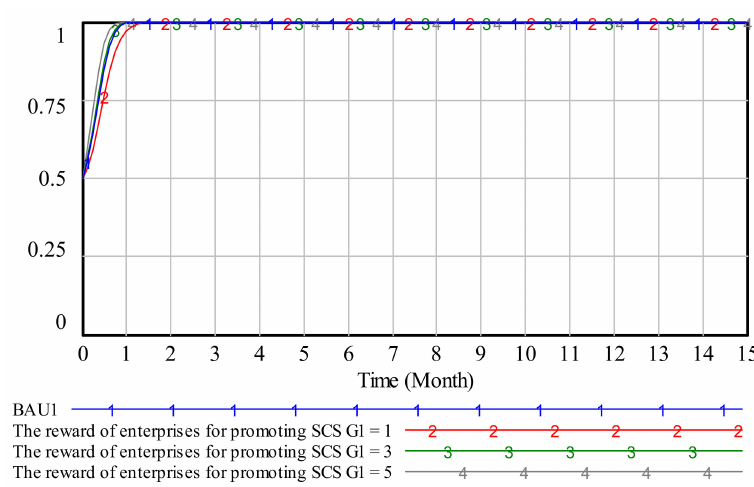
Figure 12. Impact of P 1 on enterprise strategy selection in the BAU1 scenario.